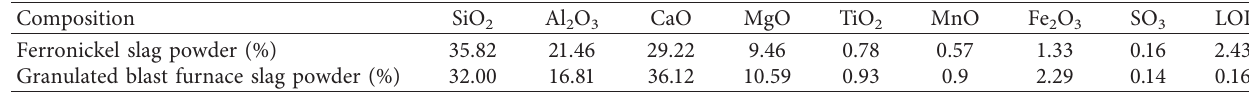
Table 2: Chemical composition of compound admixture.